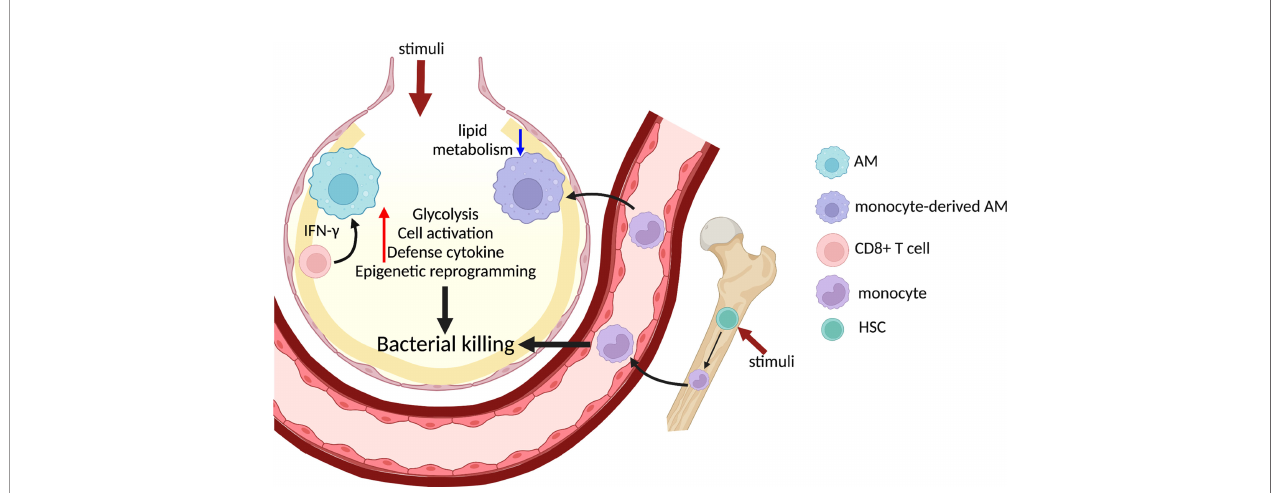
FIGURE 2 | Trained immunity in lung macrophages promotes host defense against bacterial infection. Systemic administration of BCG or b -glucan activates HSC and induces myelopoiesis in the bone marrow and generates trained monocytes/macrophages. Direct administration of various stimuli to the alveolar space also triggers trained immunity in AMs, which is dependent on IFN g from CD8 + T cells. Monocytes are recruited to the in fl amed lung and differentiate into monocyte-derived AMs, a population which displays reduced lipid metabolism and enhanced bacterial killing. Trained lung macrophages alter chromatin accessibility and undergo extensive metabolic rewiring, which result in elevated glycolysis and cytokine production to further promote bacterial clearance in the lung. HSC, homeostatic stem